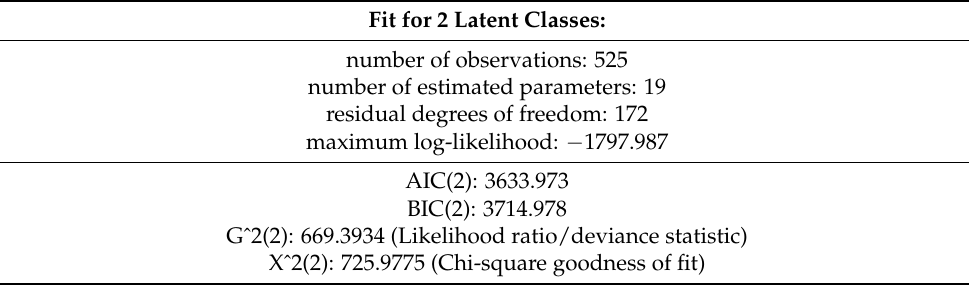
Figure 7. Estimated class population shares and estimated class-conditional response probabilities. Table 8. Latent class model goodness-of-fit